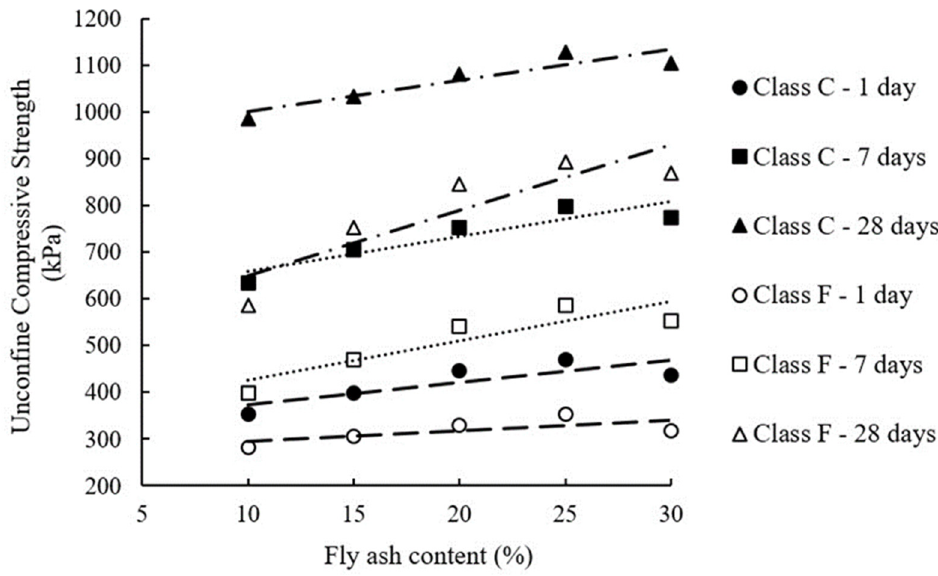
Figure 6. Effect of the fly ash content on the unconfined compressive strength of clay.